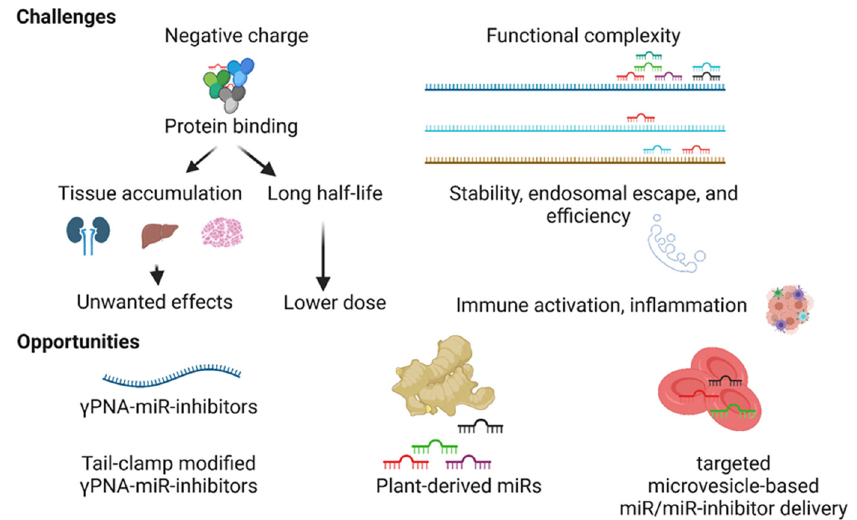
Figure 4. Challenges and opportunities in the development of miR therapeutics. The negatively charged miR inhibitors nonspecifically bind to blood proteins, promoting the half-lives and nonspe- cific tissue accumulation of molecules leading to unwanted effects. Hundreds of miRs target a single mRNA, and in turn, a single miR targets hundreds of genes, making target miR selection challeng- ing. The stability, endosomal escape, and specificity of the miR inhibitor and adverse effects such as immune activation impede the development of miR therapeutics. Next-generation γ -modified PNA-based miR inhibitors, tail-clamp modification to the structures of miR inhibitors, plant-derived miRs, and targeted microvesicle-based delivery approaches present opportunities to resolve some of the challenges in the development of miR therapeutics.